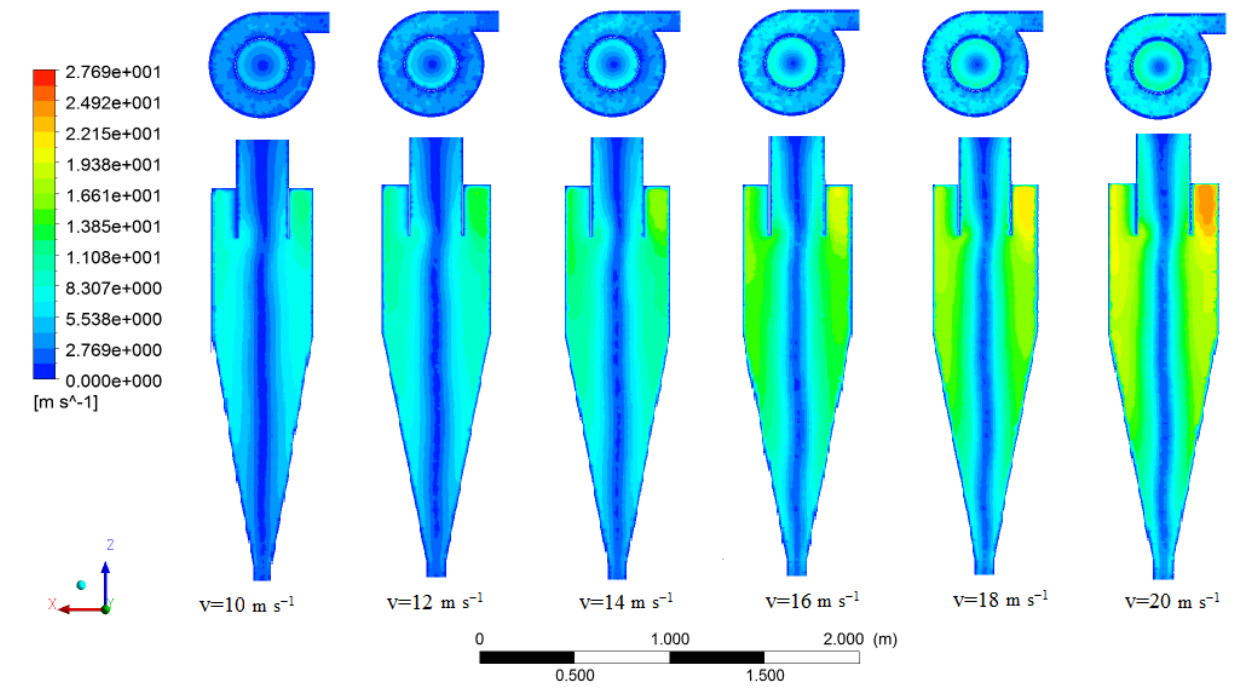
Figure 9. Tangential velocity contours in various inlet velocities.